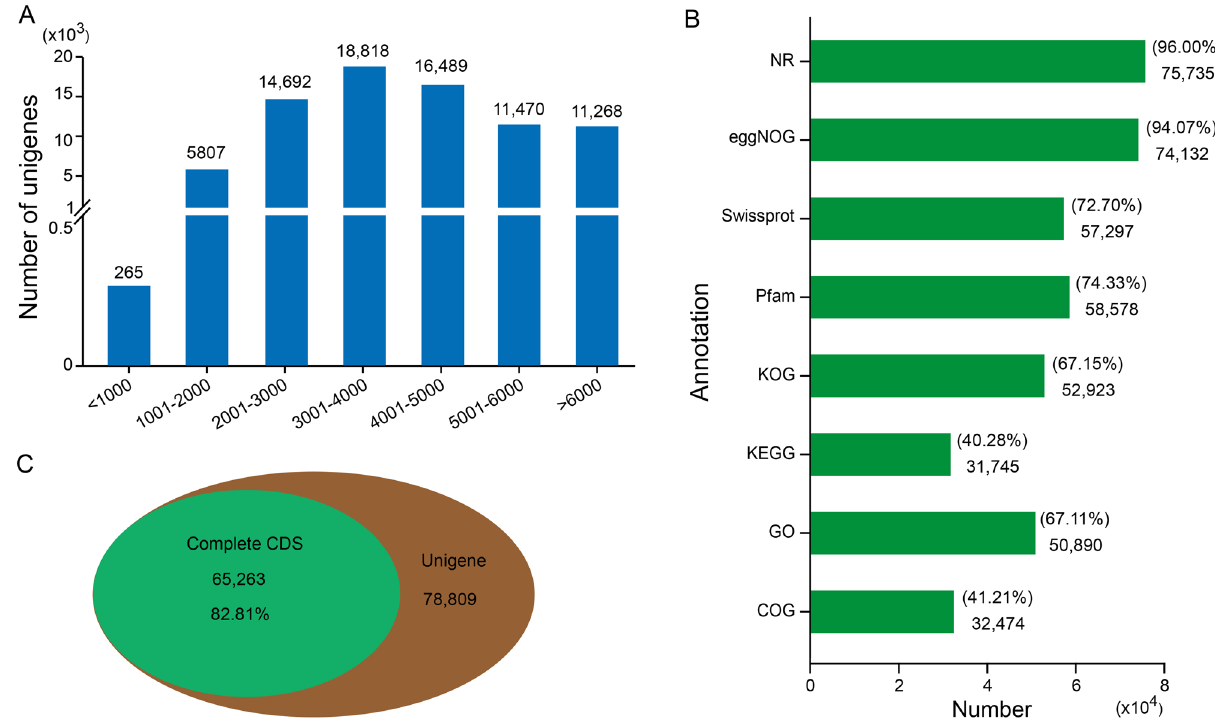
Figure 3. Characteristics of full-length transcriptome sequencing. ( A ) Length distribution of the unigenes. ( B ) Number and percentage of annotated genes in different database. ( C ) Number of complete coding